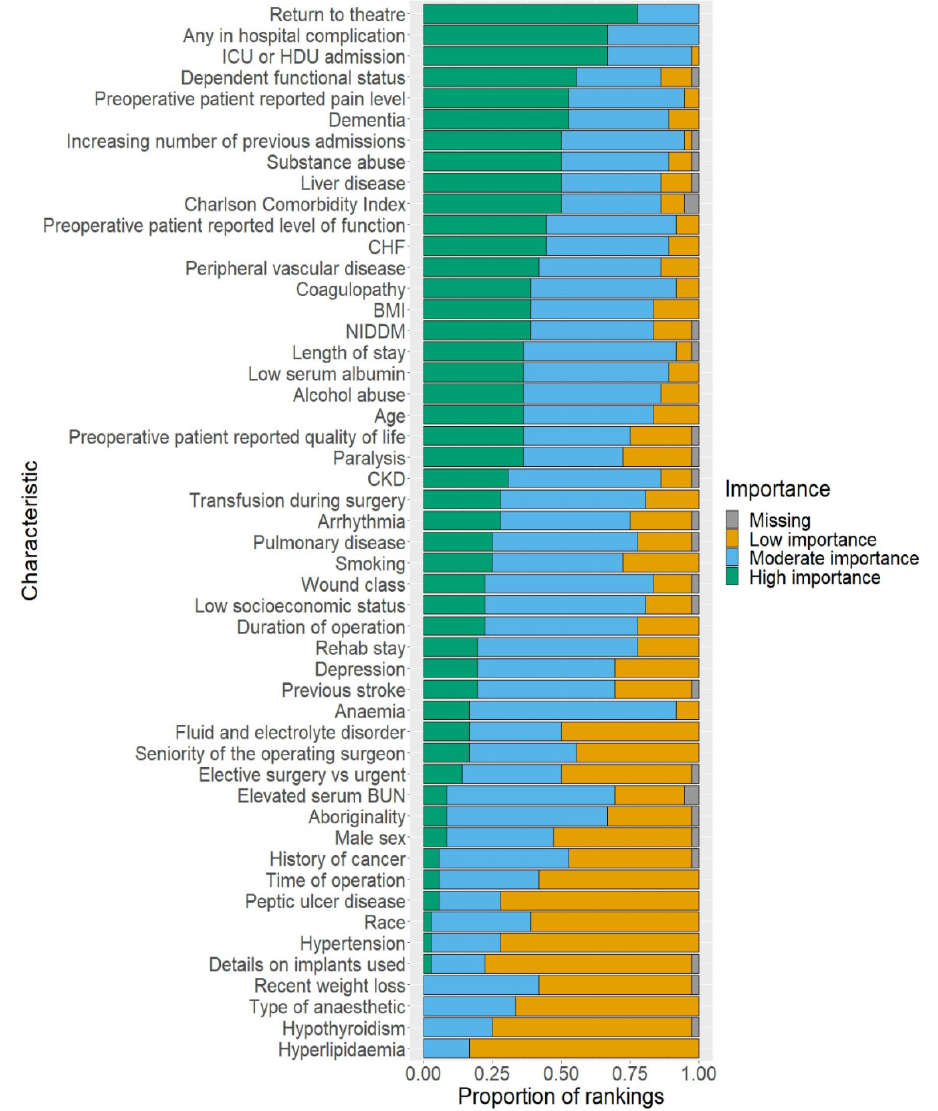
Figure 2. Counts of votes—Delphi survey. ICU = intensive care unit; HDU = high dependency unit; CHF = congestive heart failure; CKD = chronic kidney disease; NIDDM = non-insulin-dependent diabetes mellitus; BMI = body mass index.